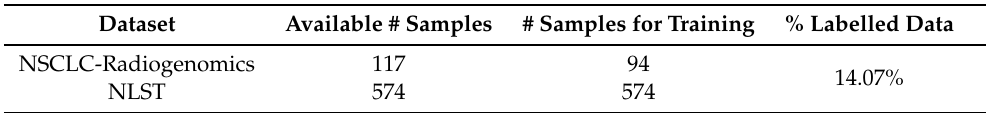
Table 3. Percentage of labelled data when using the entire NLST